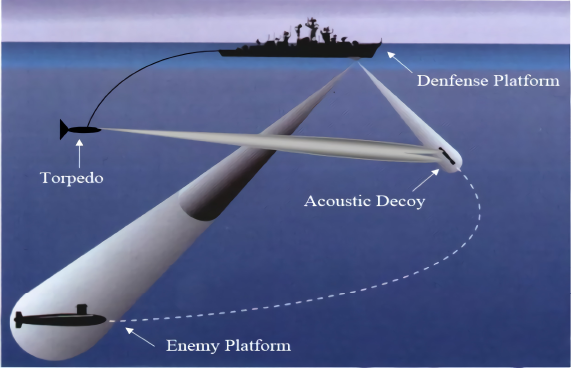
Figure 1. The defense platform’s underwater acoustic warfare posture.